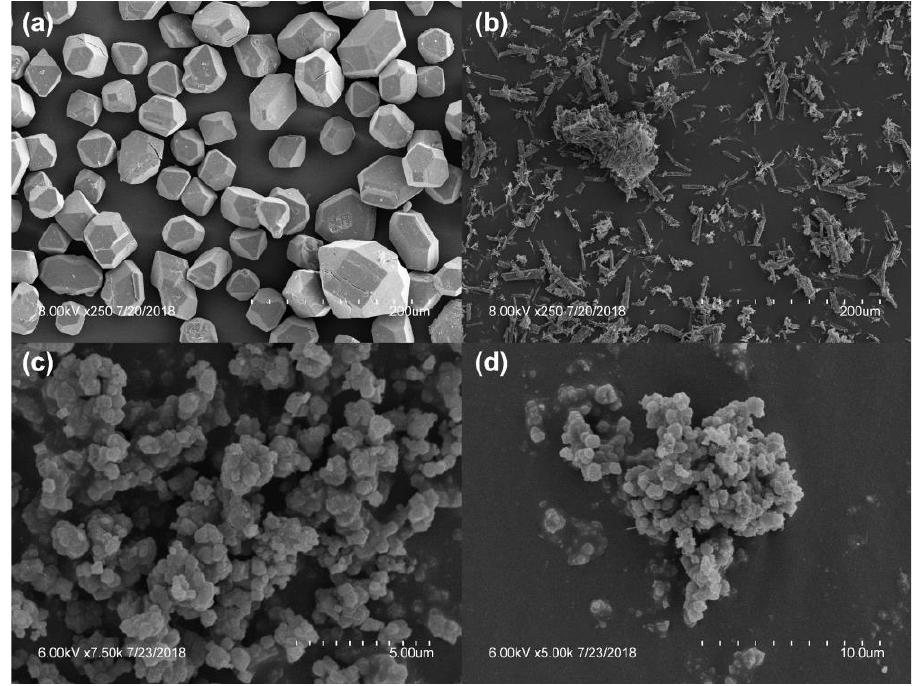
Figure 2. SEM micrographs of ( a ) Cu-BTC; ( b ) Cu-BTC/MO; ( c ) ZIF-8; ( d ) ZIF-8/MO.